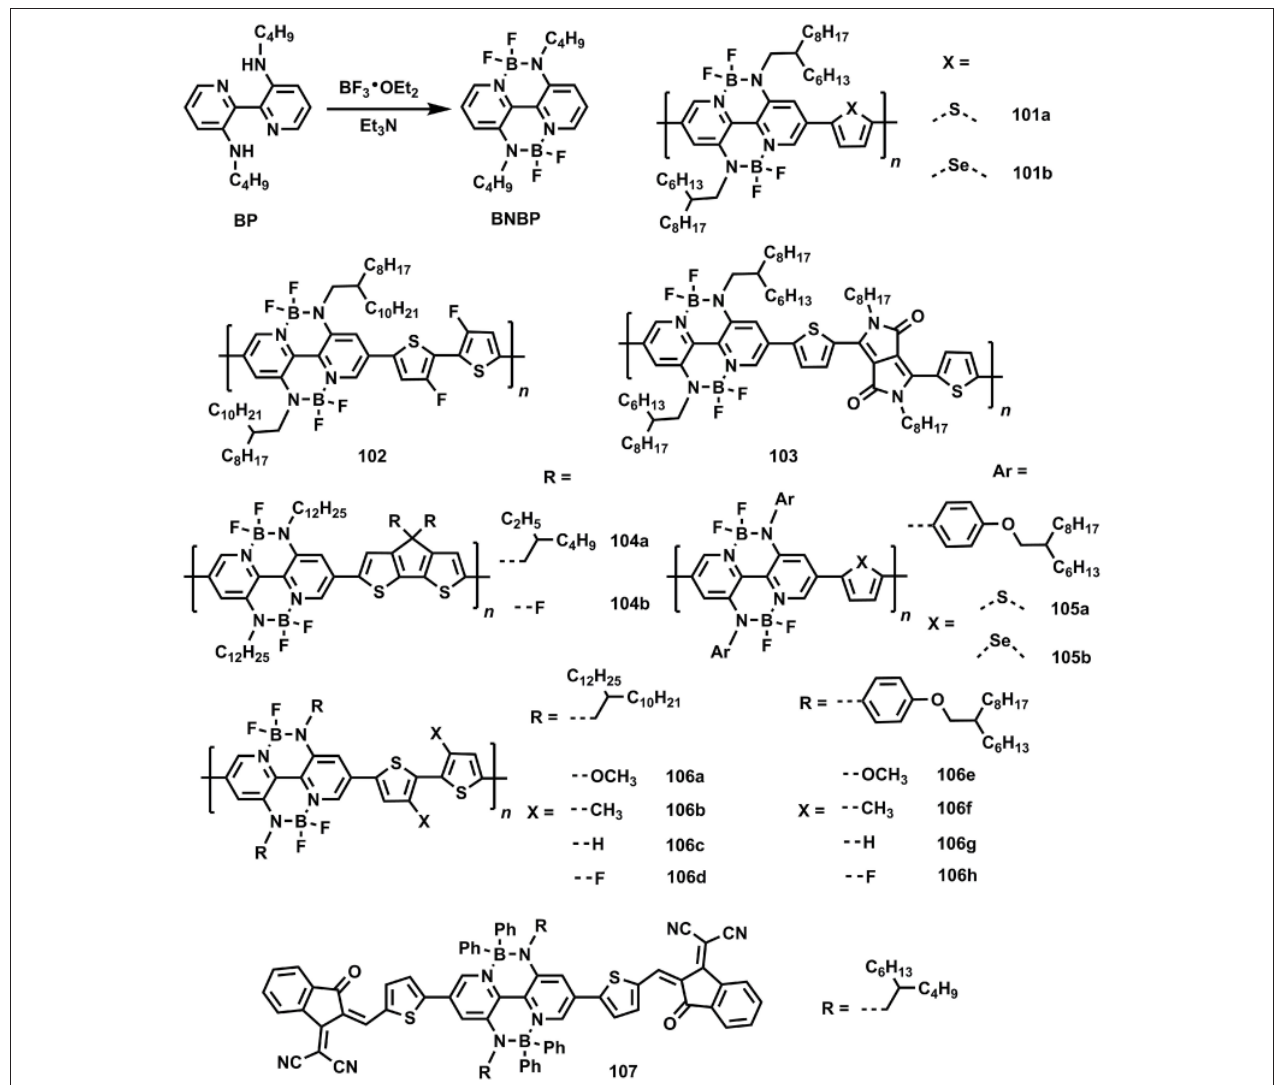
FIGURE 15 | Molecular structures of BNBP-based photovoltaic